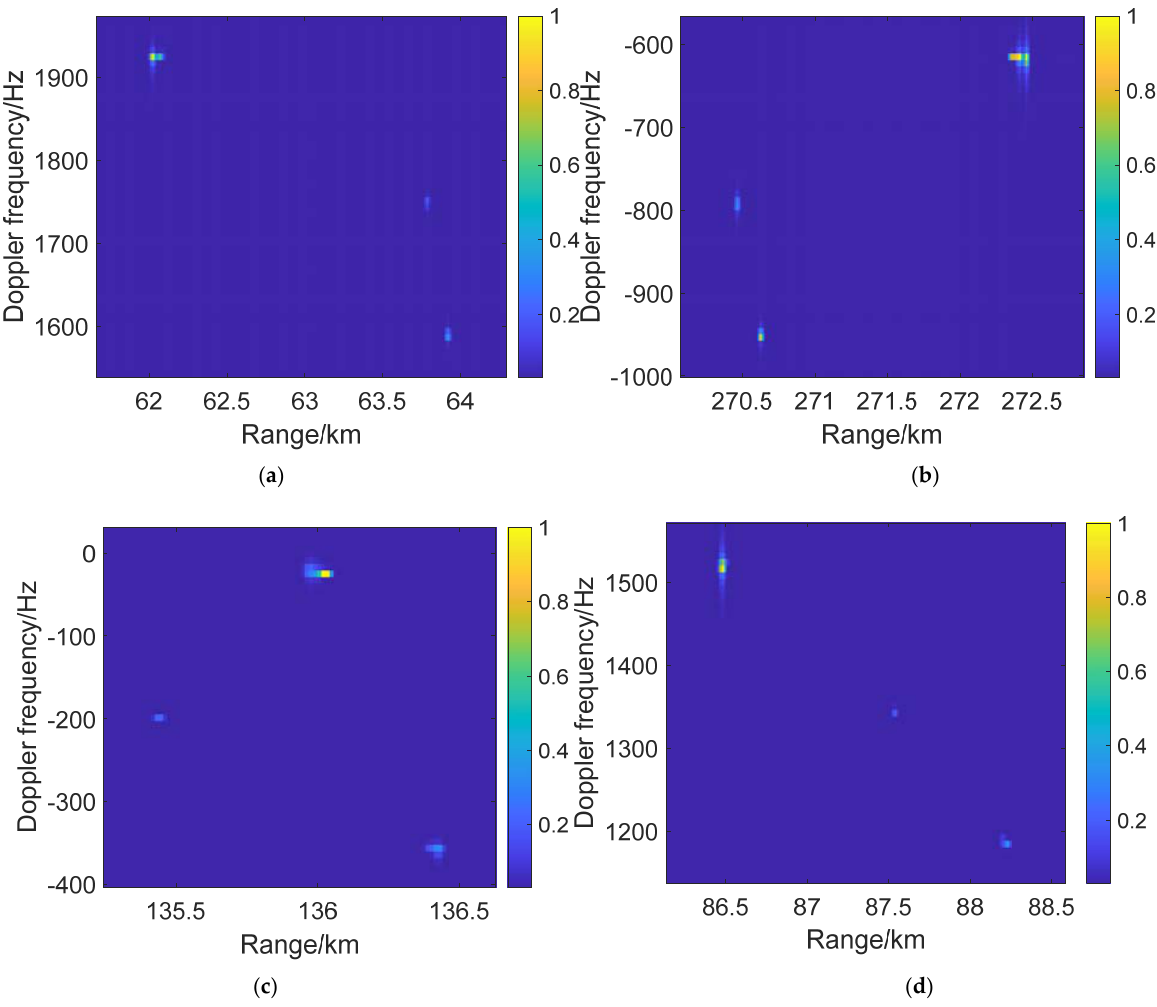
Figure 10. DDM of point targets under the detection of 4 BDS satellites: ( a ) satellite 1; ( b ) satellite 2; ( c ) satellite 3; and ( d ) satellite 4.